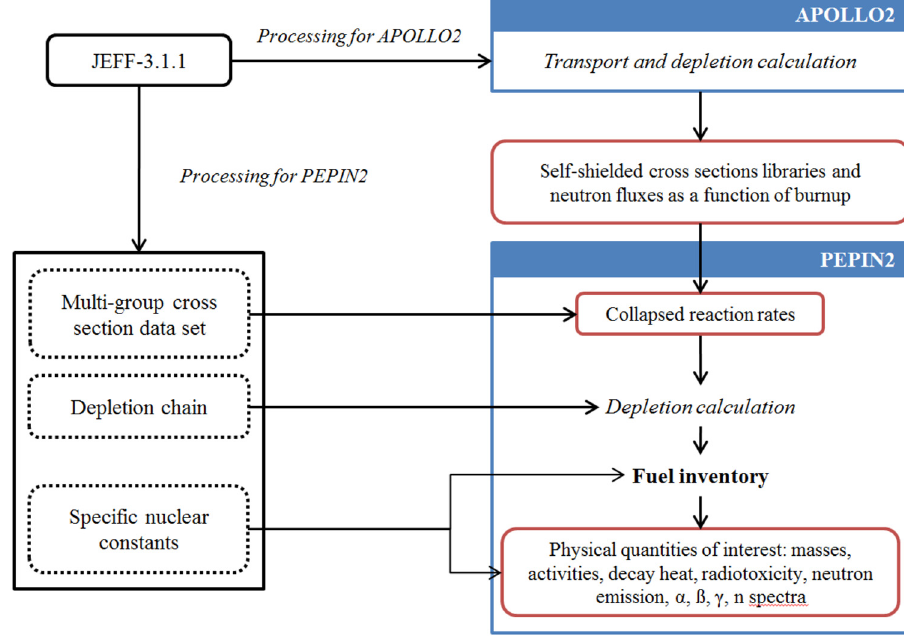
Fig. 1. Flow chart of the DARWIN2.3 package for PWR